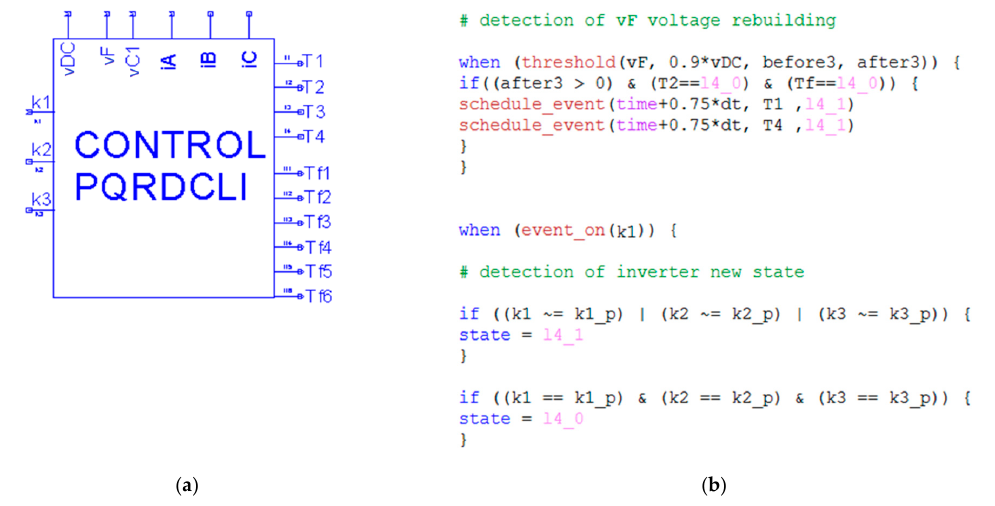
Figure 4. Model of the PQRDCLI control system: ( a ) SABER@Sketch symbol; ( b ) exemplary part of code written in MAST programming language.